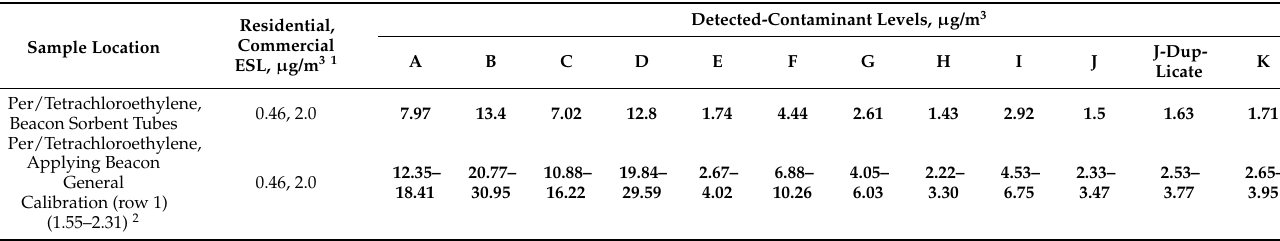
Table 5. PCE Indoor-Air, Passive-Sorbent-Sampler Interpretation of Results, Calibrated Generally per Beacon Canister- Comparison Study, 1 Former Naval Ordnance Testing Station, Pasadena, California (NOTSPA). Bold = Violations.